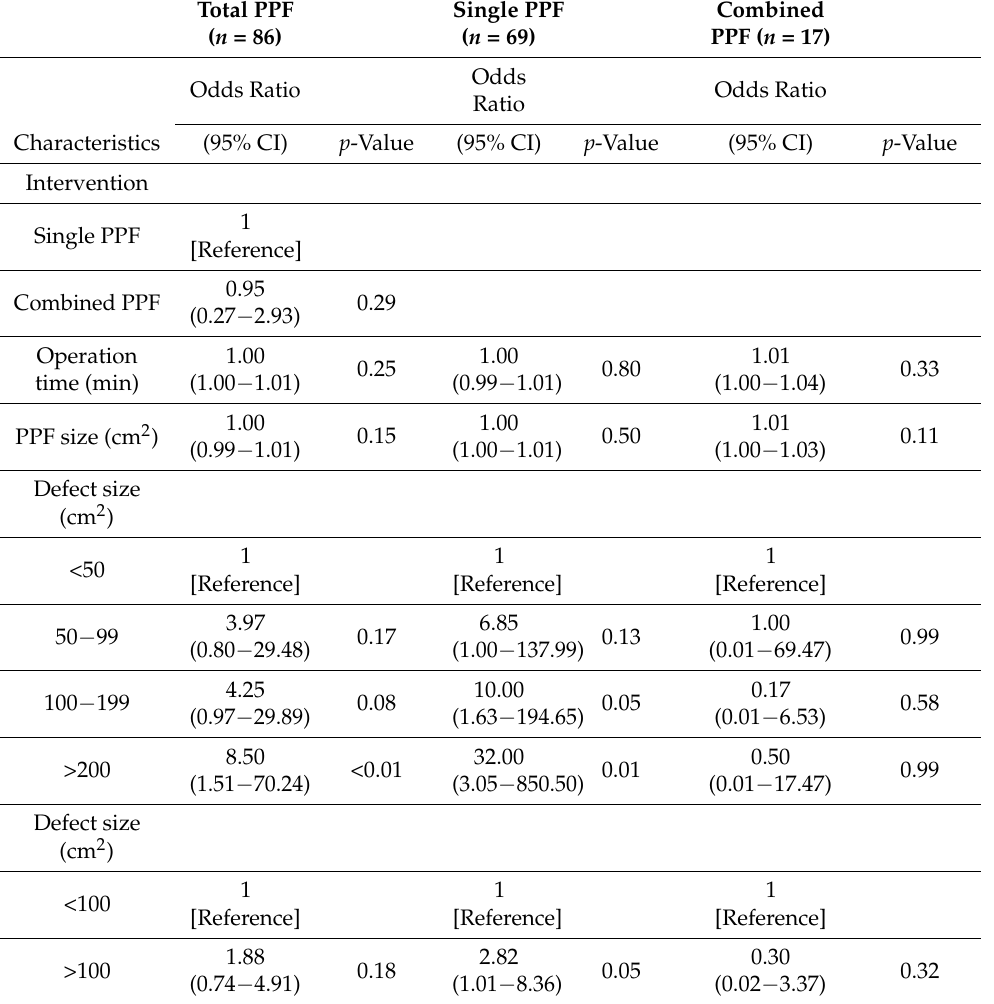
Table 4. Univariable binary logistic regressions of major complications among 86